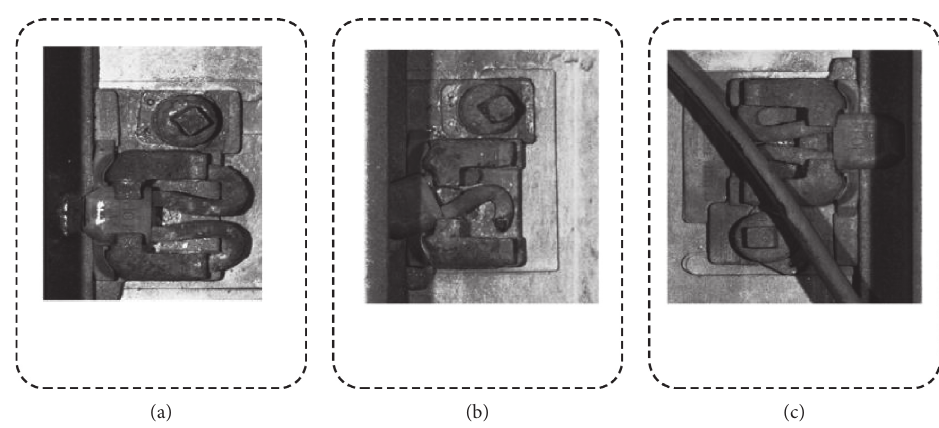
Figure 12: Position of the damaged rail fasteners. (a) The image of loose fastener. (b) The image of broken fastener. (c) The image of fastener obscured by cables.